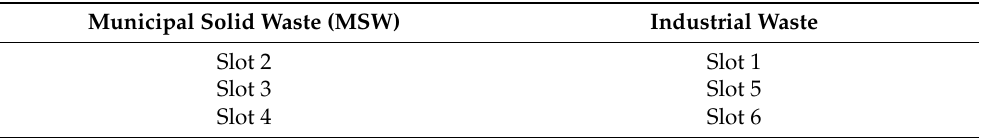
Table 1. Municipal solid waste (MSW) and industrial waste.